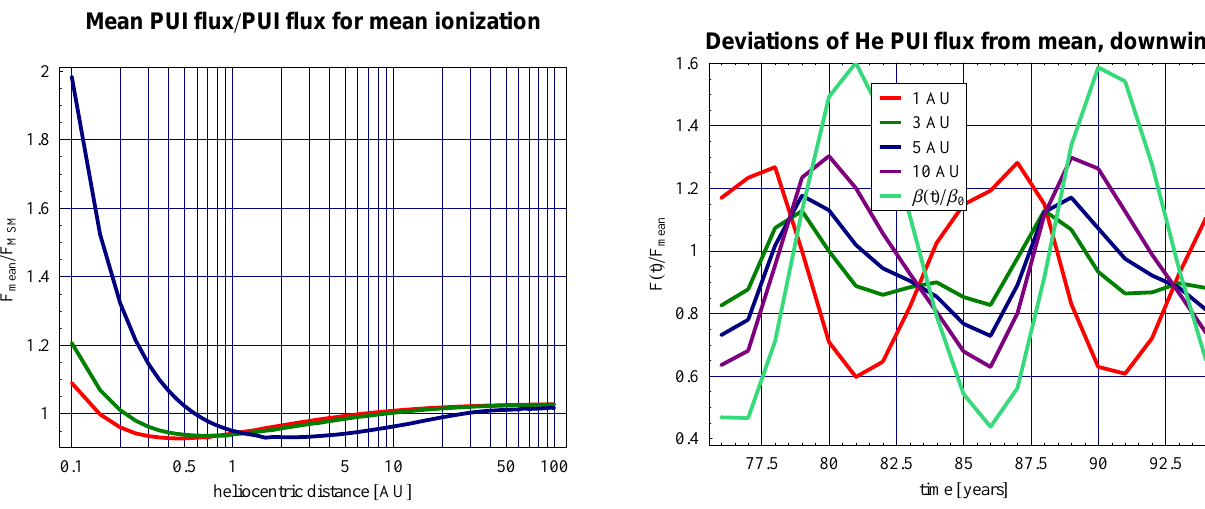
Fig. 13. Deviations of He + pickup flux from the solar-cycle mean value, for the crosswind axis at selected heliocentric distances, indi- cated in the inset box. For reference, deviations of the photoioniza- tion rate from the mean value β (t)/β mean are shown, as indicated in the box.